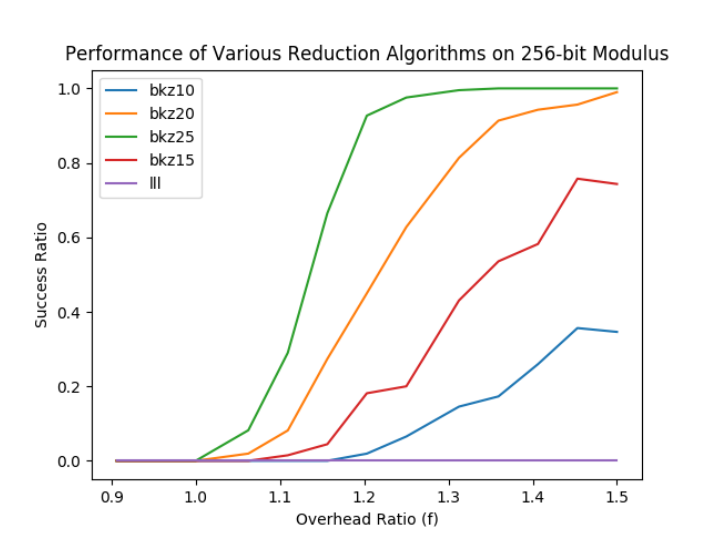
Figure 3: Performance of various reduction algorithm when solving the HNP for a 256 bit modulus. This data is for the chosen-plaintext attack with l = 4. As the block size increases, the minimum overhead ratio needed for good performance